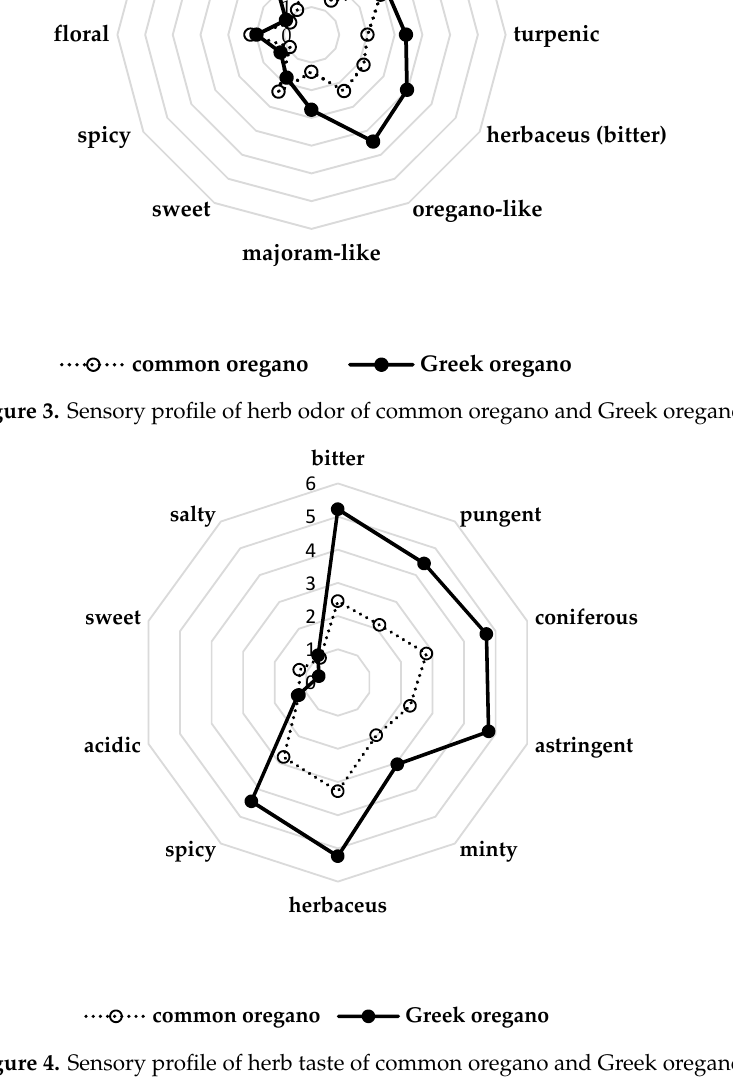
Figure 4. Sensory profile of herb taste of common oregano and Greek oregano.